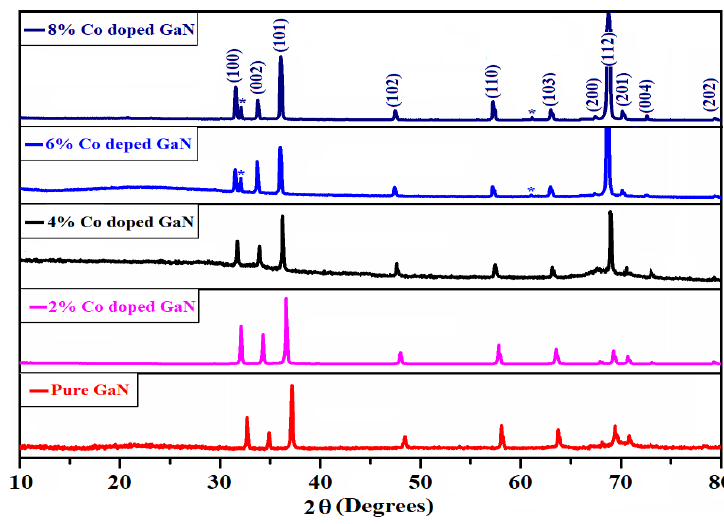
Figure 2. X-ray diffraction of pure and cobalt doped (2%, 4%, 6% and 8%) GaN nanowires. Figure 2. X-ray di ff raction of pure and cobalt doped (2%, 4%, 6% and 8%) GaN